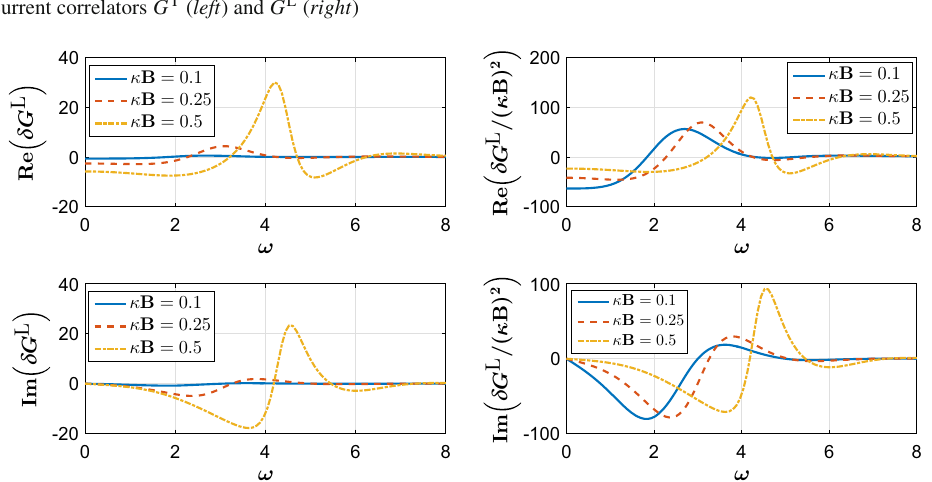
Fig. 4 Current–current correlators G T ( left ) and G L ( right )